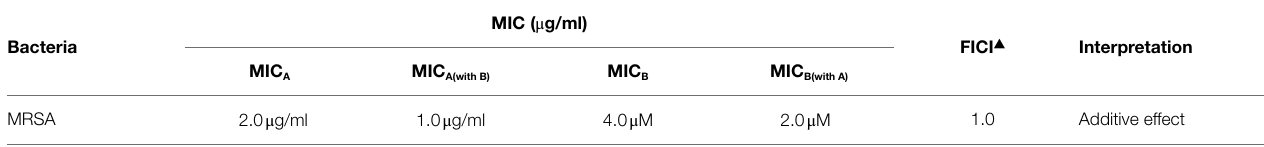
TABLE 4 | FICI measurement results of gentamicin combined with